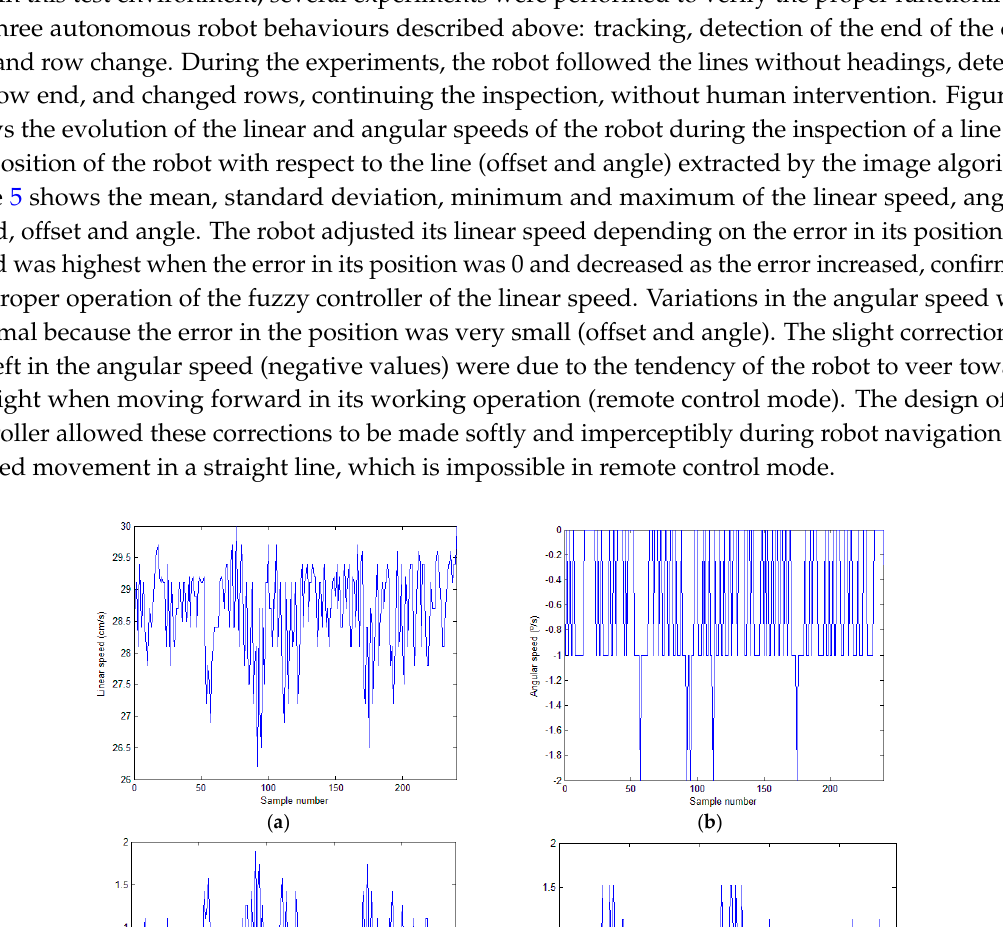
Table 5. Results obtained in the test